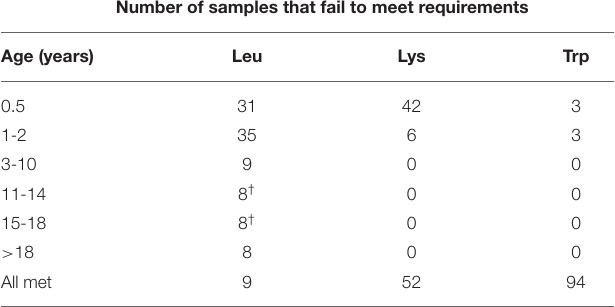
TABLE 6 | Number of samples ( n = 100) that fail to meet the daily requirements for each essential amino acid within each age group, and the number of samples that meet all age group requirements for each amino acid (i.e., all